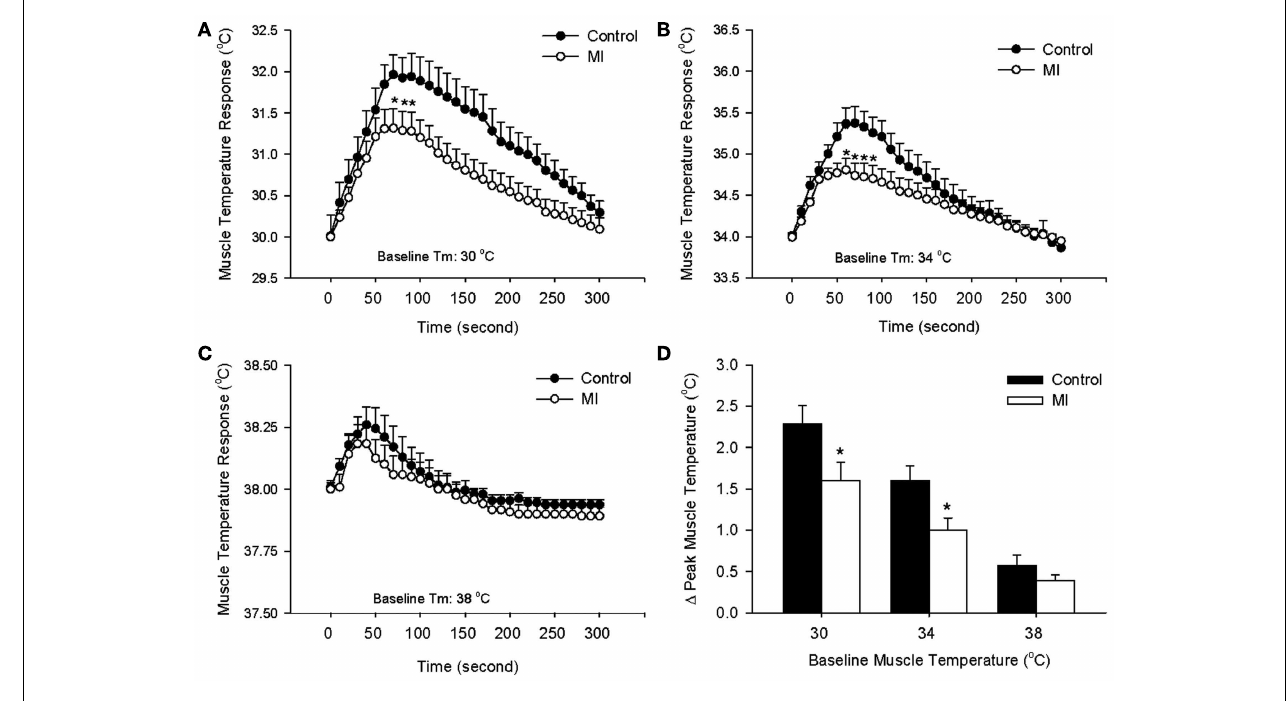
contraction at three levels of basal T m are shown in (D) .Values are means ± SE (Control: 9 rats; MI: 10 rats).The increases in T m during contraction were significantly lower in MI at baseline T m of 30, 34˚C. * P < 0.05, compared with healthy control